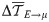
Inferred values of ΔT¯E→μ for the low IPTG experiment as a function of the length N of the time series generated by the modified model.Panels (a) and (b) correspond to sampling times τ = 6 min and τ = 1 min, respectively. ΔT¯E→μ(∞) is the exact asymptotic value.